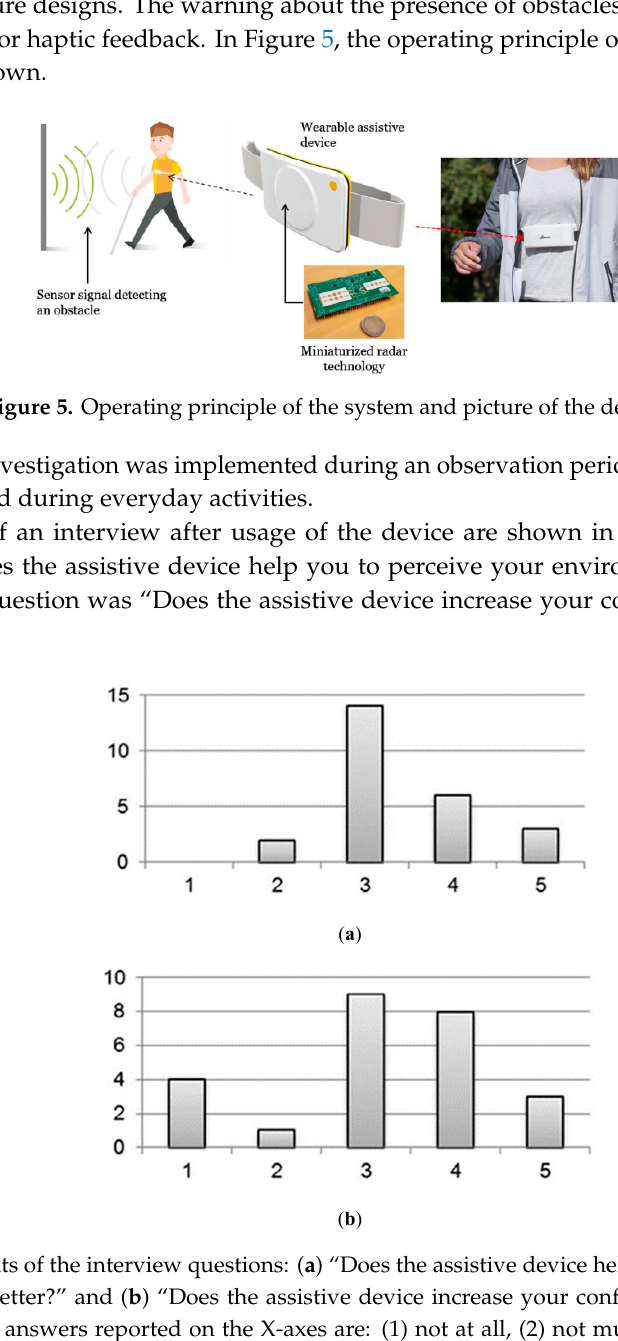
Figure 5. Operating principle of the system and picture of the device [20].